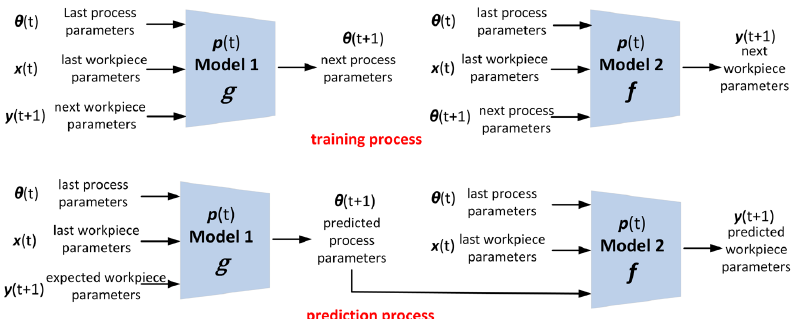
Figure 6. Flow chart of dual model training and prediction.